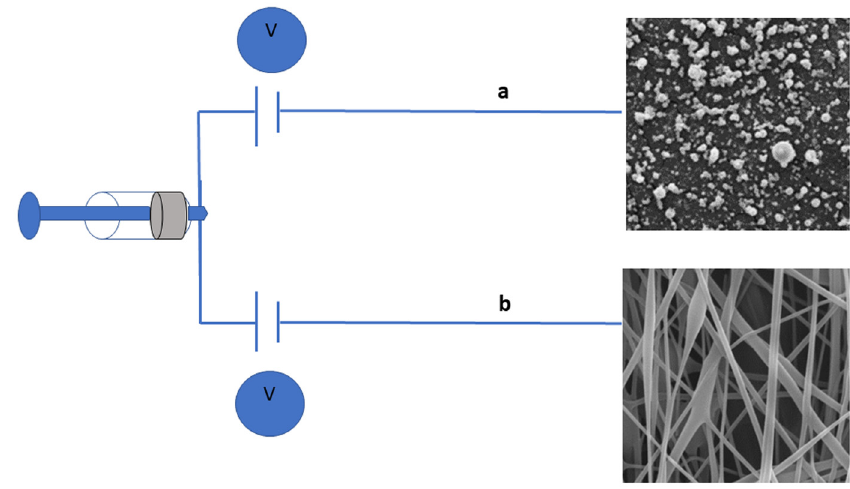
Figure 10: Schematic illustration of electro spraying ( a ) and electrospinning ( b ) . Source: